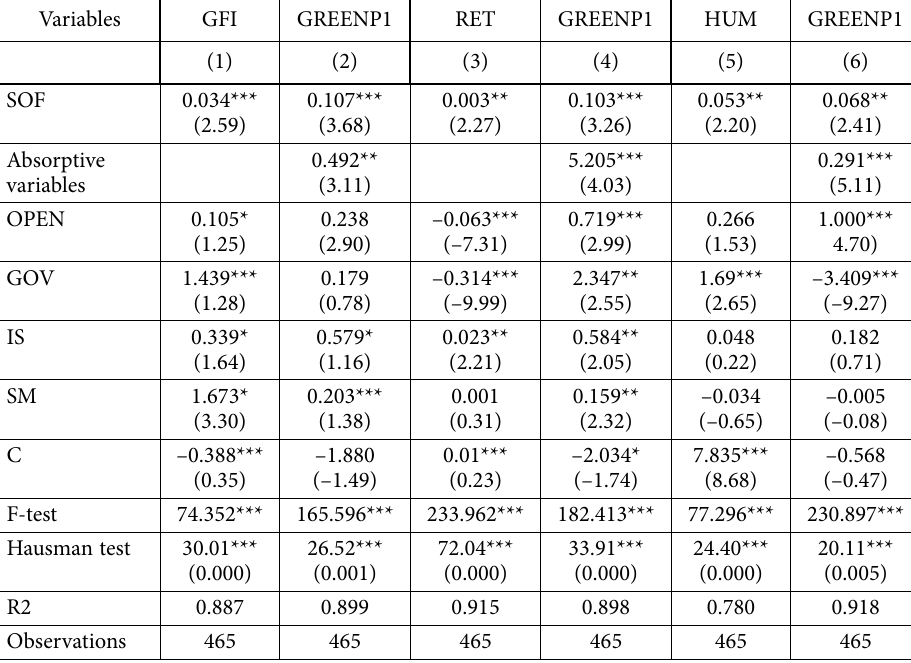
Table 3. Regression results of mediating